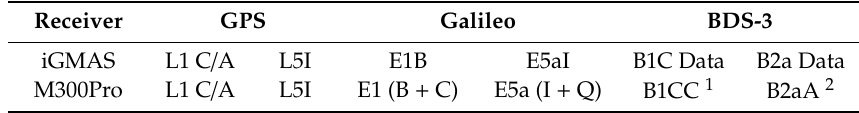
Table 3. The observables including tracking mode for the iGMAS and M300Pro